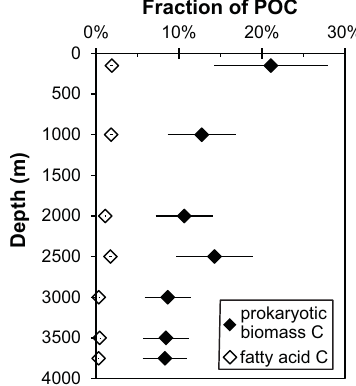
Fig. 5. Proportions of total POC that can be attributed to prokary- otic biomass and organic carbon from fatty acids (FA). Prokaryotic organic carbon calculated from abundances reported by Uchimiya et al. (2013) with a conversion factor of 6.5 ± 2.5fg carboncell − 1 (Christian and Karl, 1994; Gundersen et al., 2002) and assuming 51% recovery on GF/F filters (Lee et al., 1995). Fatty acid abun- dances converted organic carbon equivalents using the weighted av- erage %C for fatty acids at each